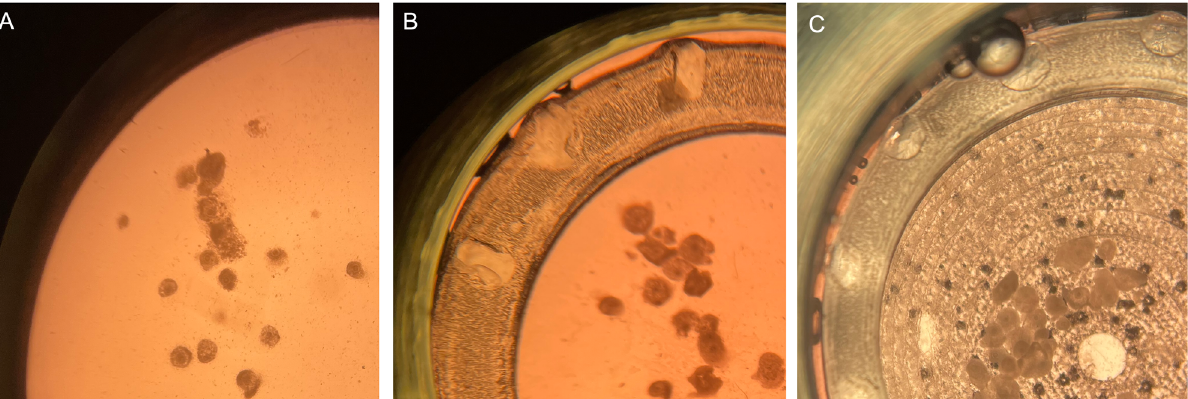
Table legend: GV: Germinal Vesicle; MI: Metaphase I; TI: Telophase I; MII: Metaphase II. Chi square